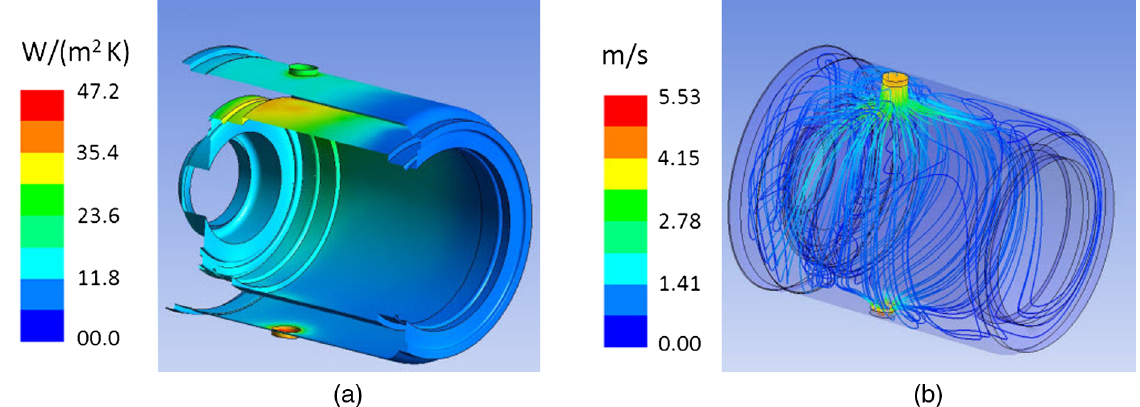
FIG. 18. Results of air cooling simulations from ANSYS .